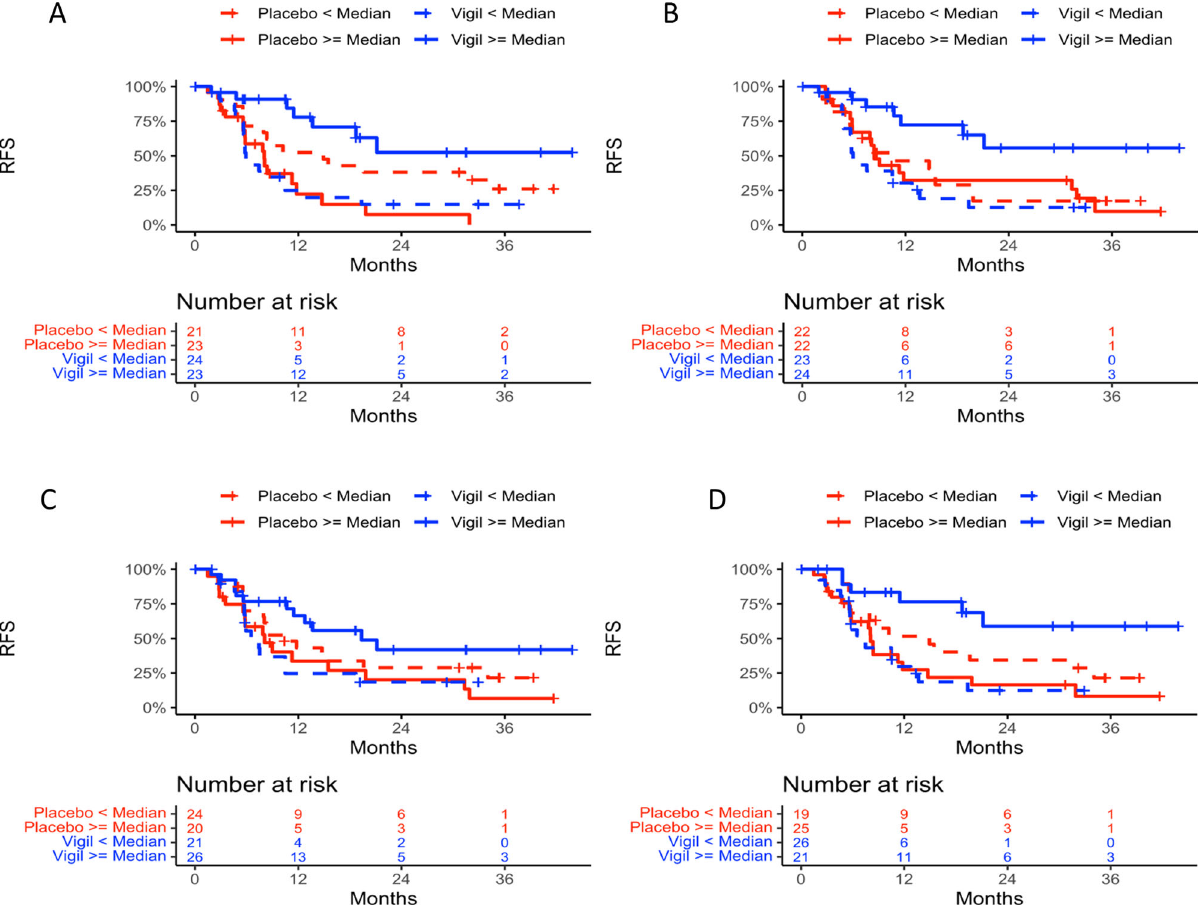
Fig. 4 Relapse free survival Kaplan Meier curves of all four genes analyzed. Relapse free survival Kaplan Meier curves of ENTPD1 / CD39 A , CCL13 B , CD79B C , and MRC1 D expression <median in Vigil ( n = 24, 23, 21, 26 respectively) and placebo ( n = 21, 22, 24, 19 respectively) and ENTPD1/CD39 , CCL13 , CD79B , and MRC1 expression ≥ median in Vigil ( n = 23, 24, 26, 21, respectively) and placebo ( n = 23, 22, 20, 25, respectively) treated patients. P values are one